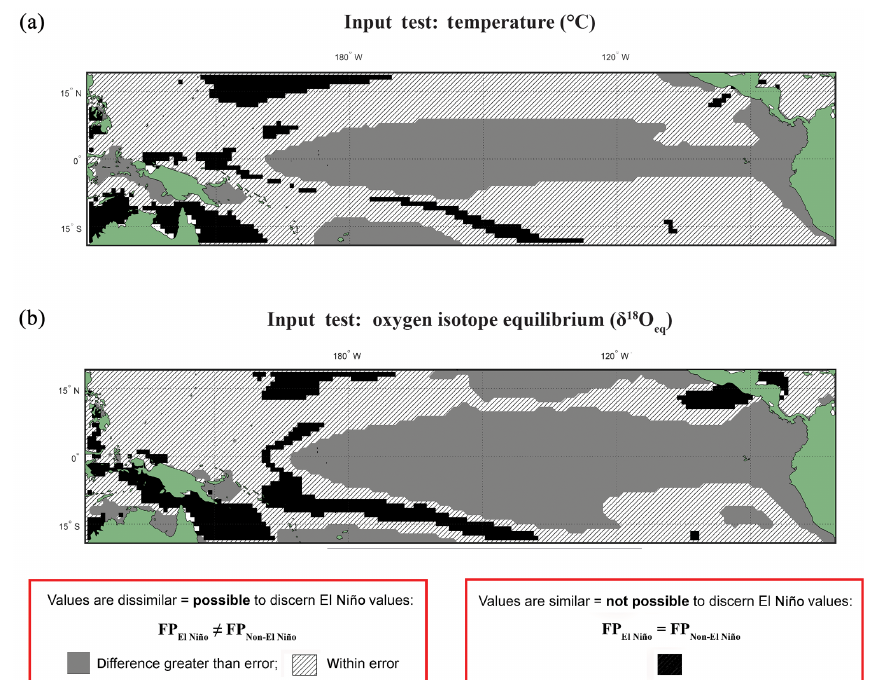
Figure 1. Anderson–Darling Results for input datasets of temperature and equilibrium δ 18 O ( δ 18 O eq ). Results of the test in which input variables underwent the same statistical procedure (see Sect. 2) as the modelled data for (a) temperature and (b) δ 18 O eq values. Here, model input data were extracted for a single depth of ∼ 5m without any growth weighting applied. Black regions are those grid points in which the null hypothesis (H 0 ), that the El Niño and non-El Niño (neutral) foraminifera populations (FPs) are not statistically different (FP ElNiño = FP Non-ElNiño ), cannot be rejected. Grey regions represent grid points where the H 1 hypothesis is accepted; therefore the distributions of the foraminiferal population for El Niño and non-El Niño can be said to be unique (FP ElNiño (cid:54)= FP Non-ElNiño ). The hatched regions represent areas were the H 1 hypothesis can be accepted; therefore the distributions of the foraminiferal population for El Niño and non-El Niño can be said to be unique (FP ElNiño (cid:54)= FP Non-ElNiño ), though the difference between the means of tested distribution are less than (a) 0.5 ◦ C or (b) 0.1‰. For a comparison with three different fixed depths (5, 149, and 235m) without any growth weighting applied see Fig.